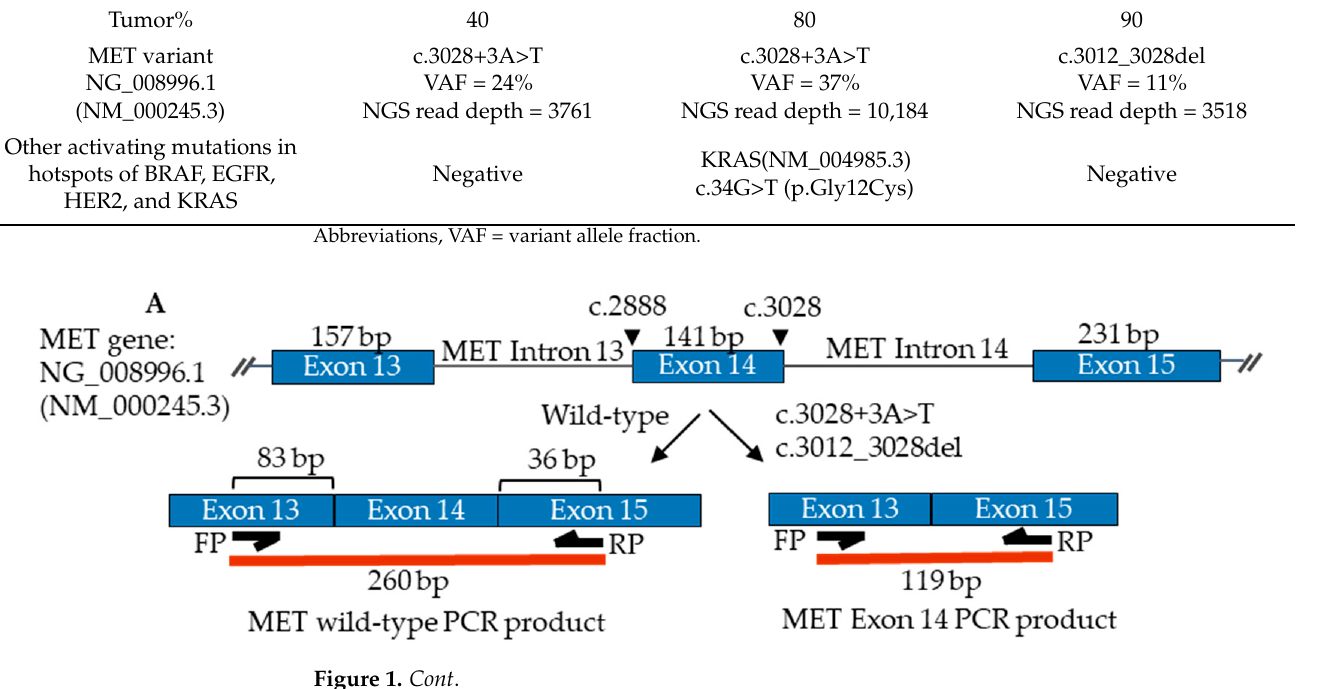
Figure 1. ( A ) Graphic representation of MET exon 13, 14, and 15 sizes, primers for RT-PCR binding sites, and predicted size of wild-type and MET exon 14 PCR products. ( B , C ) Alamut visual predic- tion of MET splicing with c.3028+3A>T and c.3012_3028del variants. With the use of four splicing predictors, donor prediction signals, shown with vertical blue bars (each bar corresponded to an individual splicing predictor) at the 5 ′ donor sites are reduced, suggesting that these variants alter splicing. Vertical green bars are for 3 ′ acceptor sites showing minimum or no change. Heights of the bars are proportional to splicing strength. Known constitutive signals are displayed as a small blue triangle for 5 ′ or a green triangle for 3 ′ .